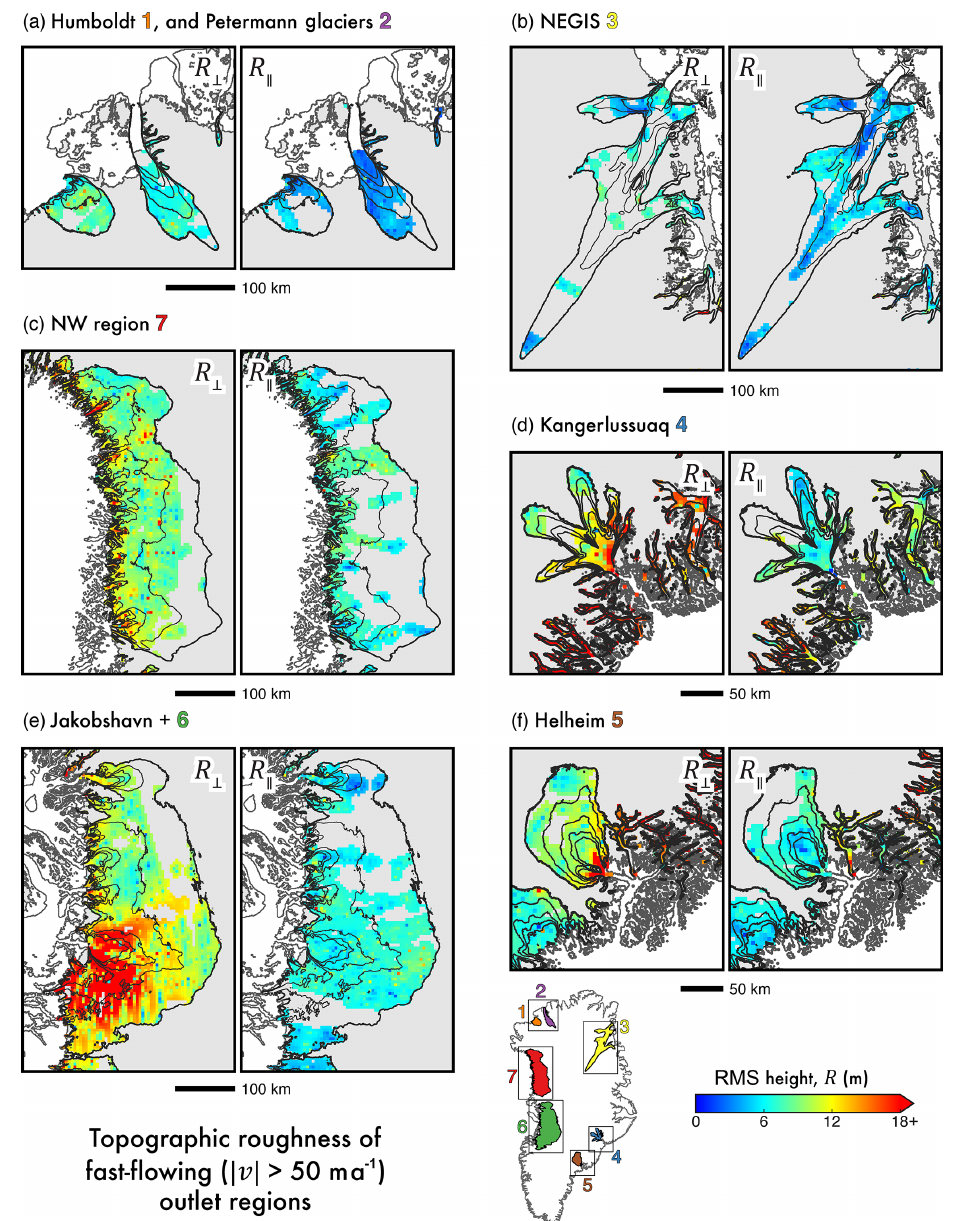
Figure 9. Local subsets of R ⊥ and R (cid:107) in fast-flowing outlet glacier regions. Interpolated R ⊥ and R (cid:107) (as Fig. 5) are shown for the fast-flowing regions of (a) Humboldt (1) and Petermann (2) glaciers, (b) the North East Greenland Ice Stream (NEGIS; 3), (c) the north-western (NW; 7) fast-flow region, (d) Kangerlussuaq (4), (e) Jakobshavn Isbræ and surrounding glaciers (6), and (f) Helheim (5). The location of these regions is inset, where regions are colour-coded for further analysis (see Fig.